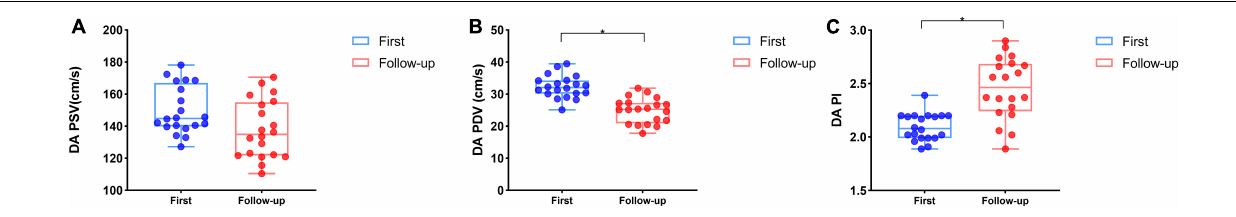
FIGURE 5 | Series examinations of DA flow spectrum for DC fetuses (Blue box and plots represent the first examination in the DC group, red box and plots represent follow-up data in the DC group). At follow-up, DA PSV had no significant difference compared with the initial examination (A) , but DA PDV (B) and DA PI (C) were significantly decreased in the DC group. * p < 0.05 compared first and follow-up examinations. PS, peak systolic velocity (cm/s); PI, pulsatility index; PDV, peak diastolic velocity (cm/s). DC, ductal constriction.